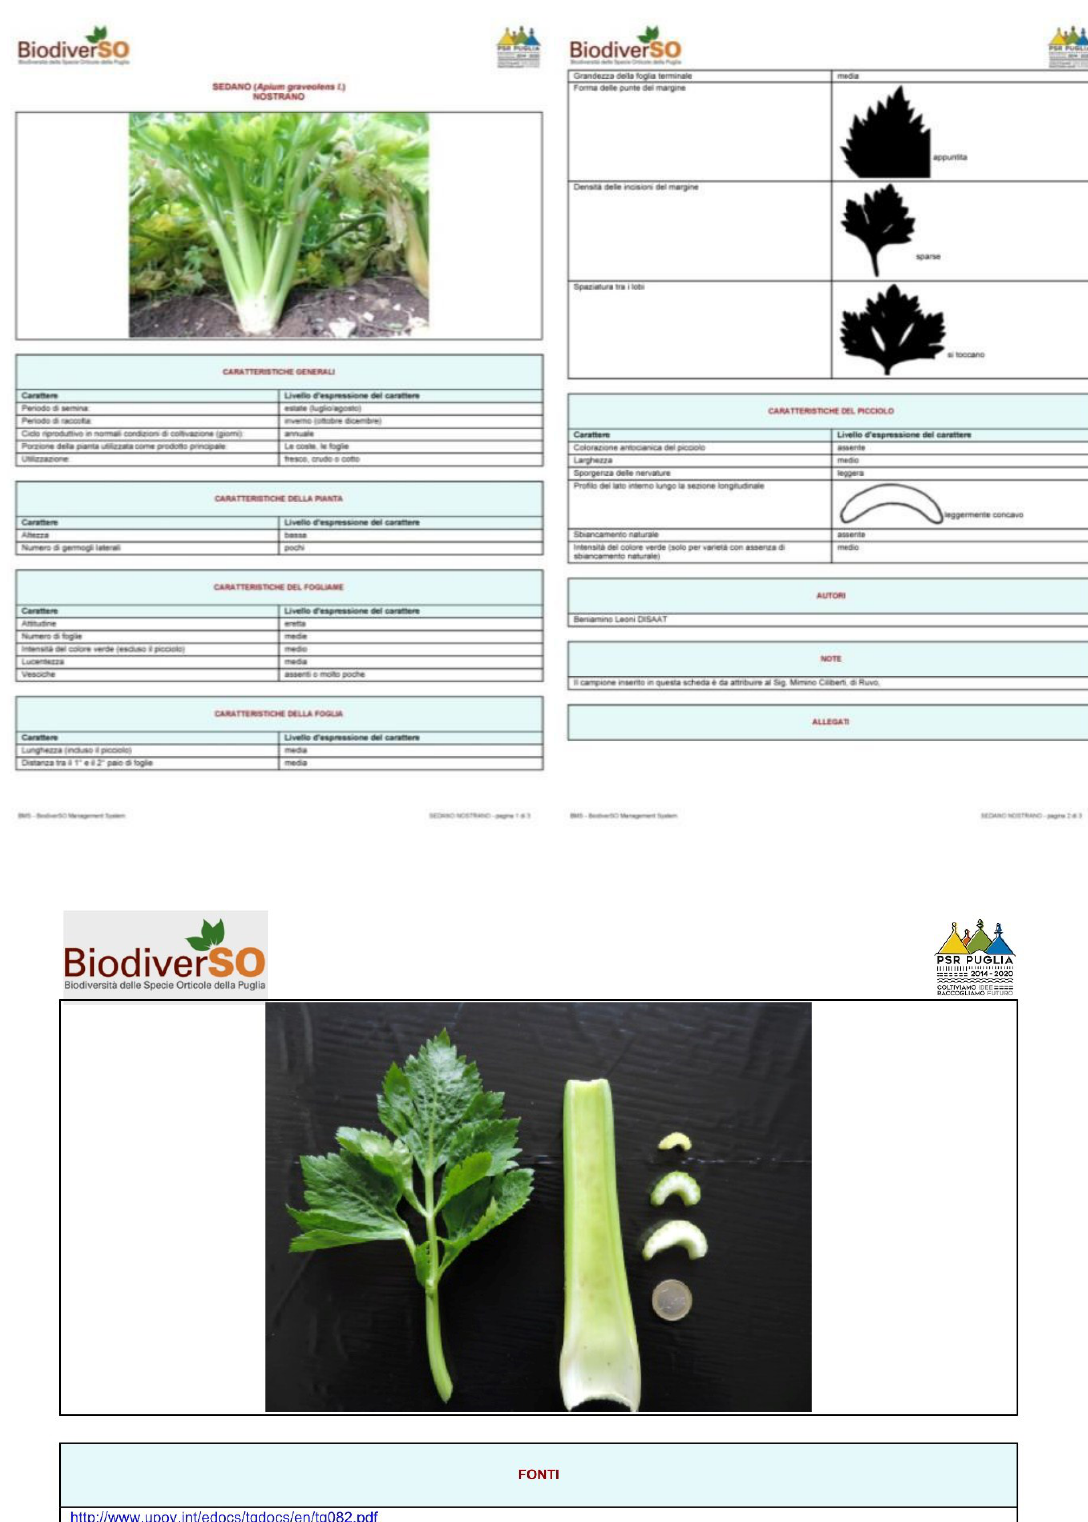
Figure 12. Examples of data sheets realized by using UPOV descriptors for a local variety of Apium graveolens L.